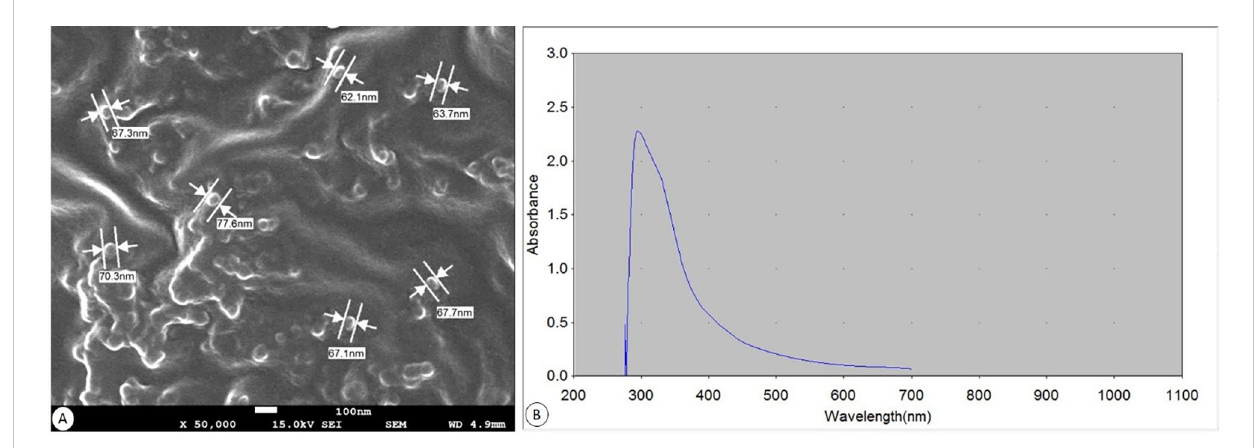
FIGURE 2 Biosynthesized SeNPs. (A) SEM at a magni fi cation of ×50.000 (scale bar= 100 nm). (B) UV spectroscopic graph showing absorbance.